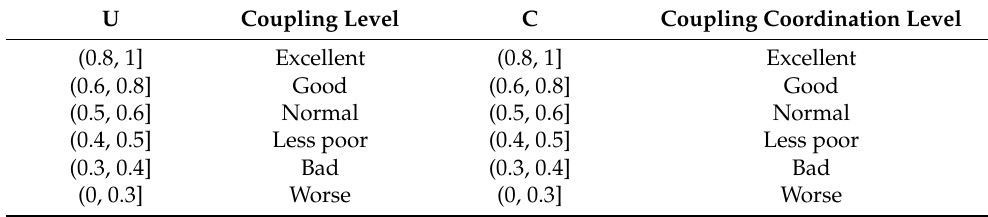
Table 1. Levels of coupling degree and coupling coordination degree.